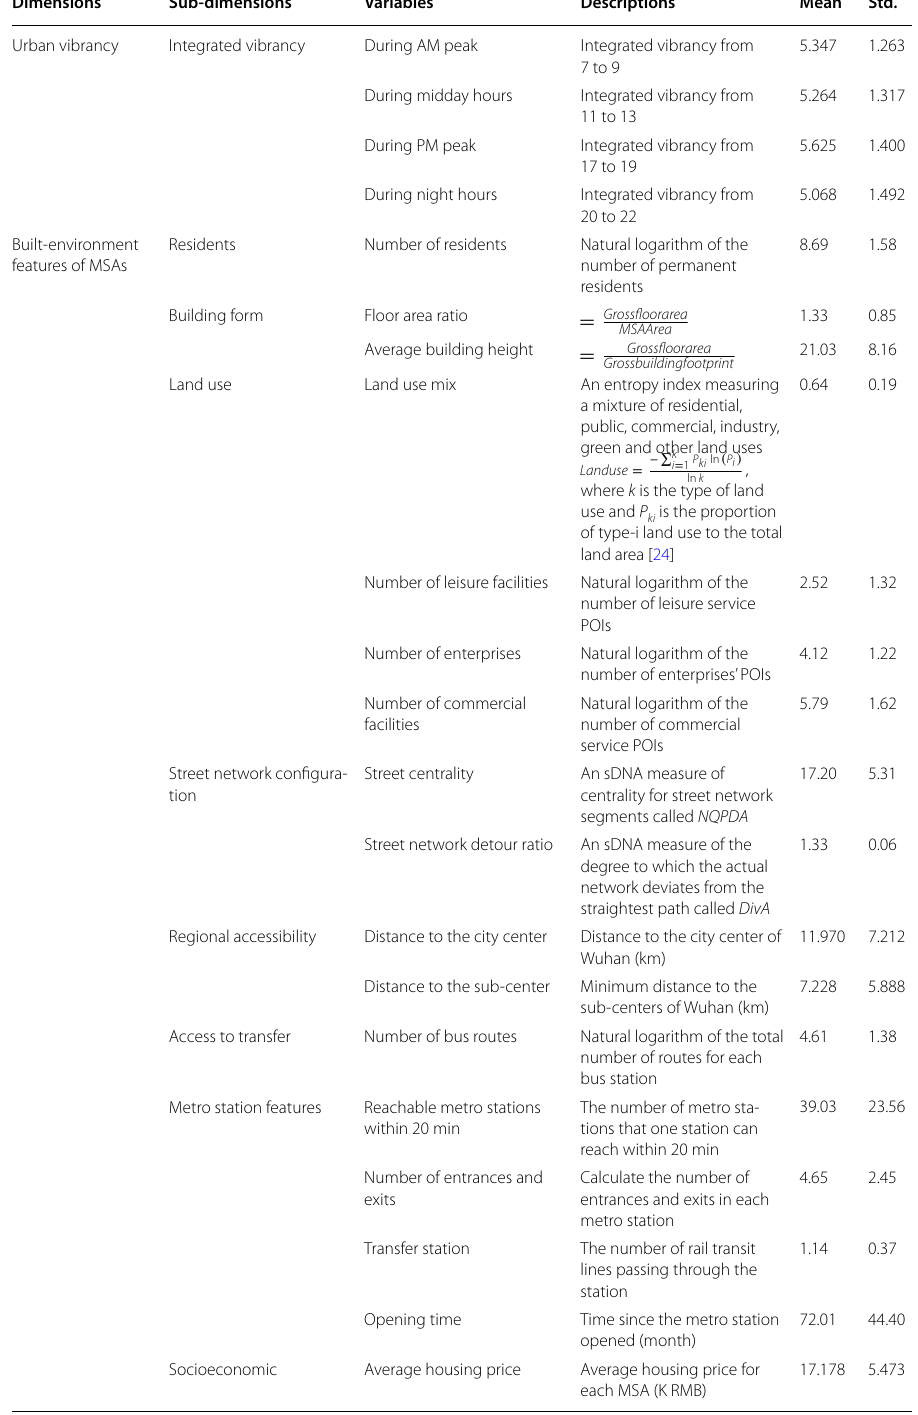
Table 2 Descriptive statistics of variables